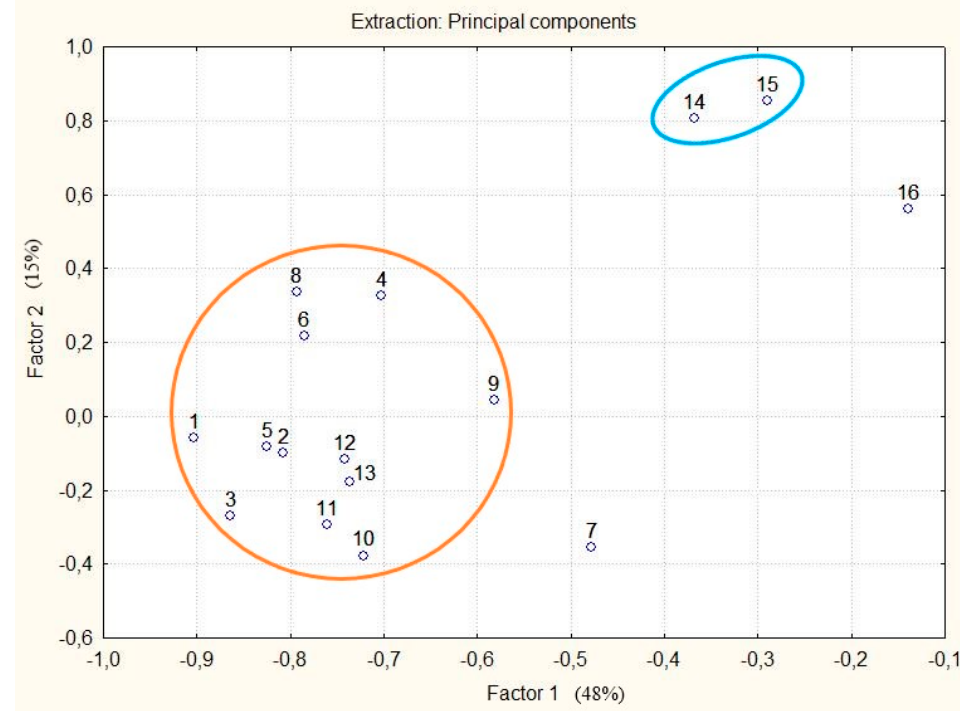
Figure 4. The principal component analysis (PCA) plot showing two clusters of callus cultures and control 1 of R. rosea . Blue ellipse: callus culture after treatment with MJ; orange ellipse: all other callus cultures in the experiment, except No. 7; No. 7: callus culture obtained on the medium that had NH 4+ /K + of 0.33, NO 3 − at 60 mM, BAP/NAA 0.33, BAP + NAA 30 μ M; No. 16: control 1. Note: see Figure 3. Table 2. Characteristics and levels of the phenolic compounds detected by HPLC in the extracts from rhizomes and roots of R. rosea